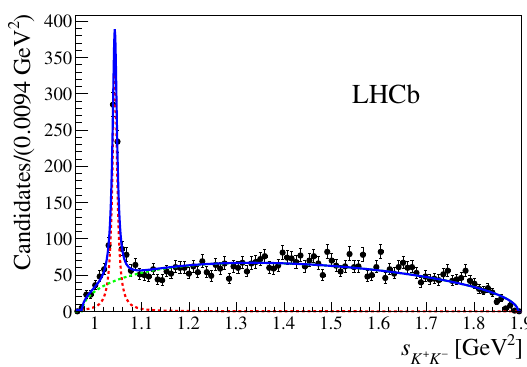
of K (cid:0) K + K + candidates with invariant mass in the range K + K (cid:0)